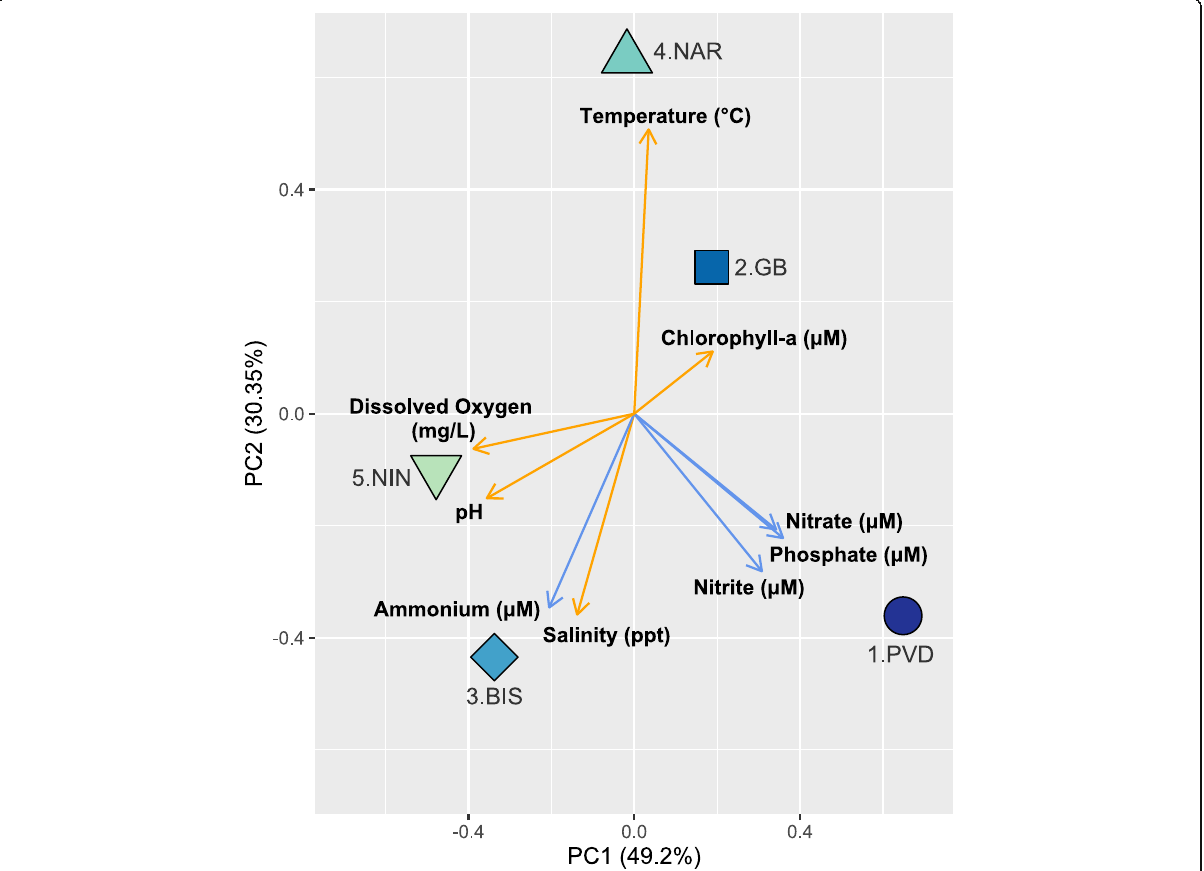
Fig. 2 Environmental conditions characterizing each site. Principal component analysis of each site is represented by a colored symbol and each environmental factor is represented with an arrow. Orange arrows indicate average environmental values measured in situ during the sampling week ( n = 2); light blue arrows represent nutrient concentrations measured from water samples ( n =